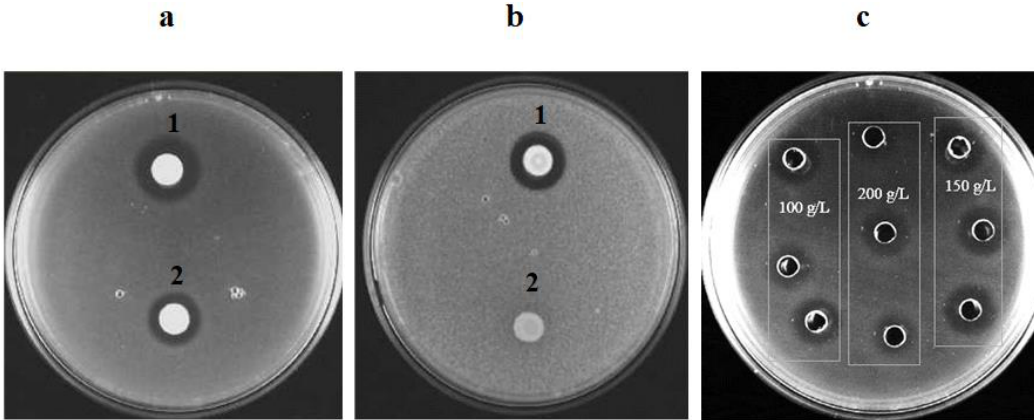
Figure 1. ( a ) Antagonistic activity of C. pyralidae (1) and P. kluyveri (2) against D. bruxellensis . ( b ) Antagonistic activity of C. pyralidae (1) and P. kluyveri (2) against Z. bailii . ( c ) Depiction of the inhibition activity of the biopreservation compounds produced by the antagonistic yeasts C. pyralidae against D. bruxellensis after 24 h of fermentation in grape pomace with varying sugar concentration (100, 150 and 200 g L − 1 ).